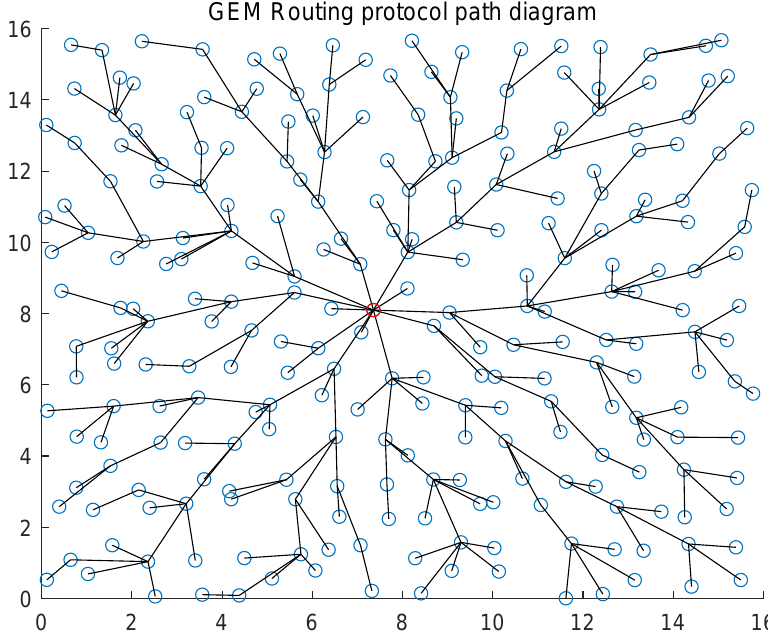
Figure 4. The figure shows the topology diagram of the WSN corresponding to GEM routing protocol. The red nod represents station. There are totally 256 nodes within the network, the maximum communication distance of nodes is 2, and 1 node is randomly distributed within each 1 × 1 square